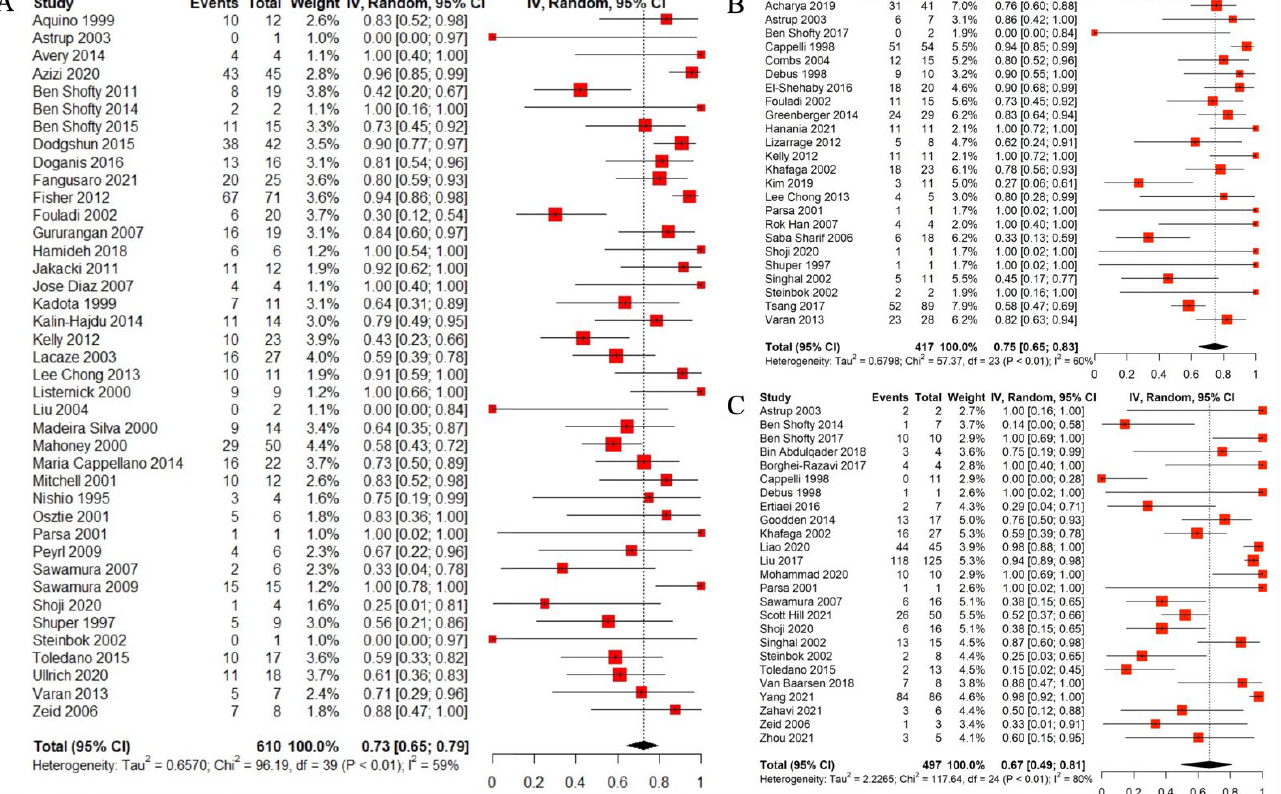
Figure 4. Forest plot for radiological outcome following each modality. ( A ) Chemotherapy, ( B ) ra- diotherapy, and ( C ) surgery [14–118].